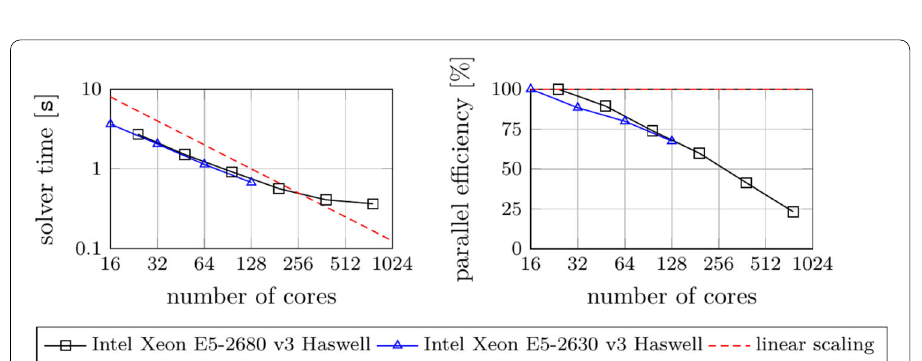
Fig. 18 Strong scaling analysis of parallel computational framework: solver time per time step (left) and parallel efficiency given in percent of linear scaling (right) for a three-dimensional problem consisting of approximately 3 . 79 × 10 6 particles on up to 768 cores